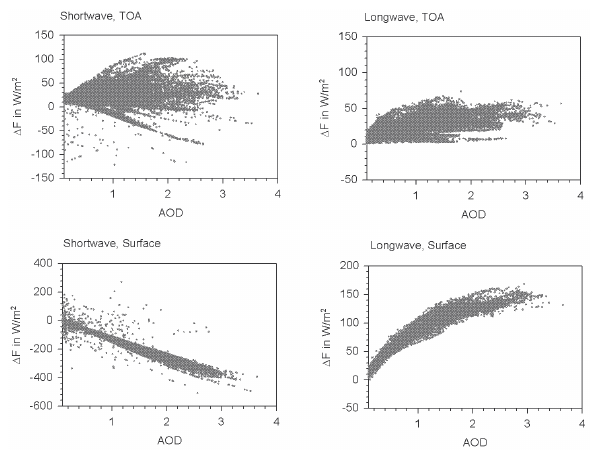
Figure 9: Difference in shortwave and longwave radiation at the surface and TOA due to mineral dust particles at 7 March 2006, 8 March 2006 and 21 June 2007, 12:00 UTC (AOD at 450 nm).